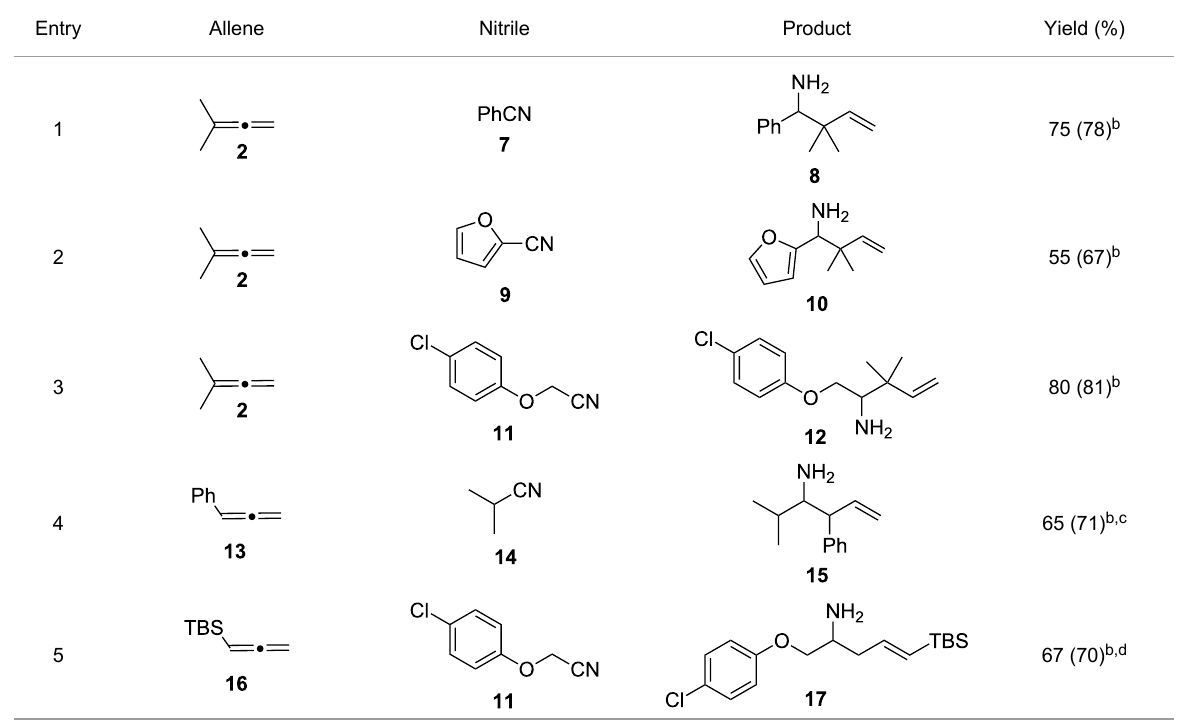
Table 2: Reductive coupling of allenes and nitriles in the presence of Cp 2 Zr(H)Cl and ZnCl 2 . a